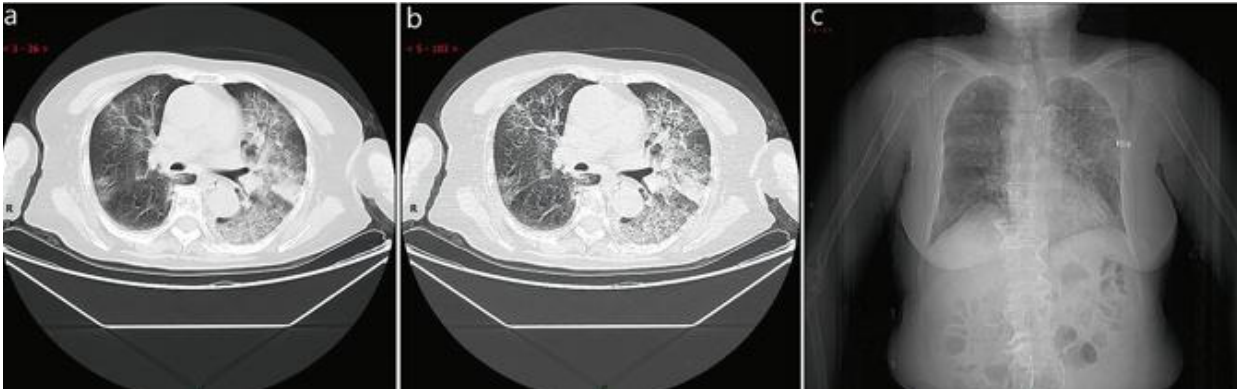
Figure 4: Atypical CT / X-ray imaging manifestation (case 1). An 83 years old female with fever for 4 days (maximum temperature of 38.8 ℃), cough, chills, sore throat, dry cough for 1 week, chest tightness and shortness of breath aggravating for 1 week. Laboratory test: normal white blood cells (4.6 × 10 9 /L), normal neutrophil percentage (65.8%), decreased lymphocytes percentage (19.9%). Imaging examination: a and b showed diffuse interlobular septum thickening in both lungs to form a grid opacity, thickening of bronchial wall, and consolidation in the left sublobal lung. c showed diffused grid-like opacities in both lungs, especially in the left lung opacity in the basal segment of the left lower